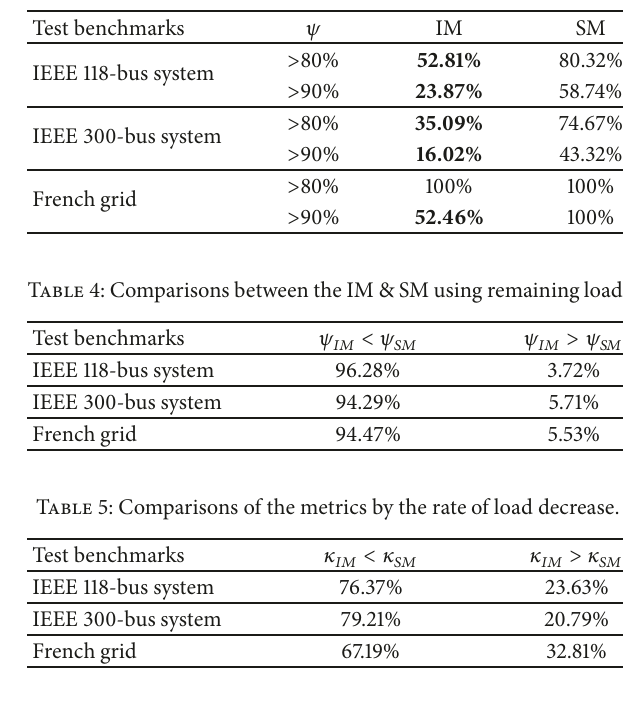
Table 3: Performances of the metrics by remaining load.